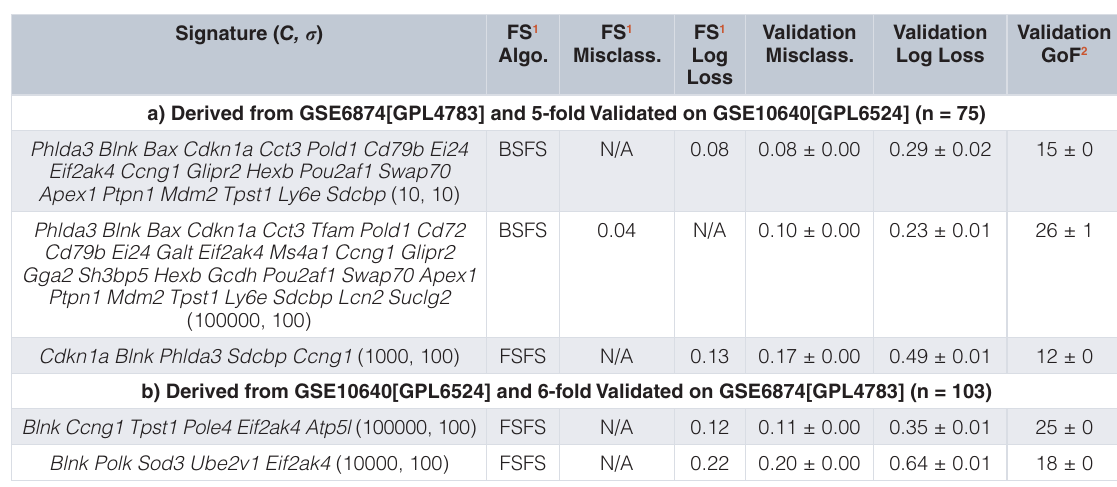
Table 1. Best murine signatures assessed by K-Fold validation.